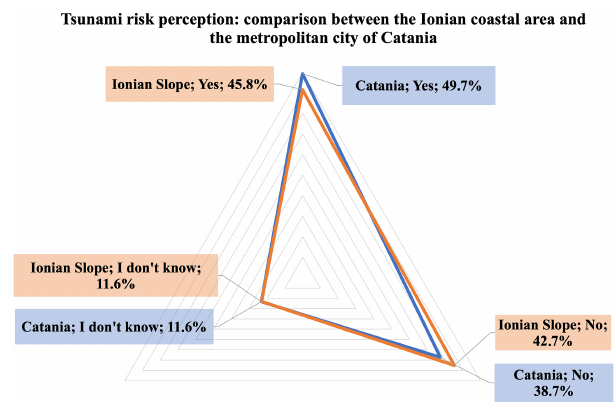
Figure 11. Tsunami risk perception (Q16): comparison between the Ionian coastal area and the metropolitan city of